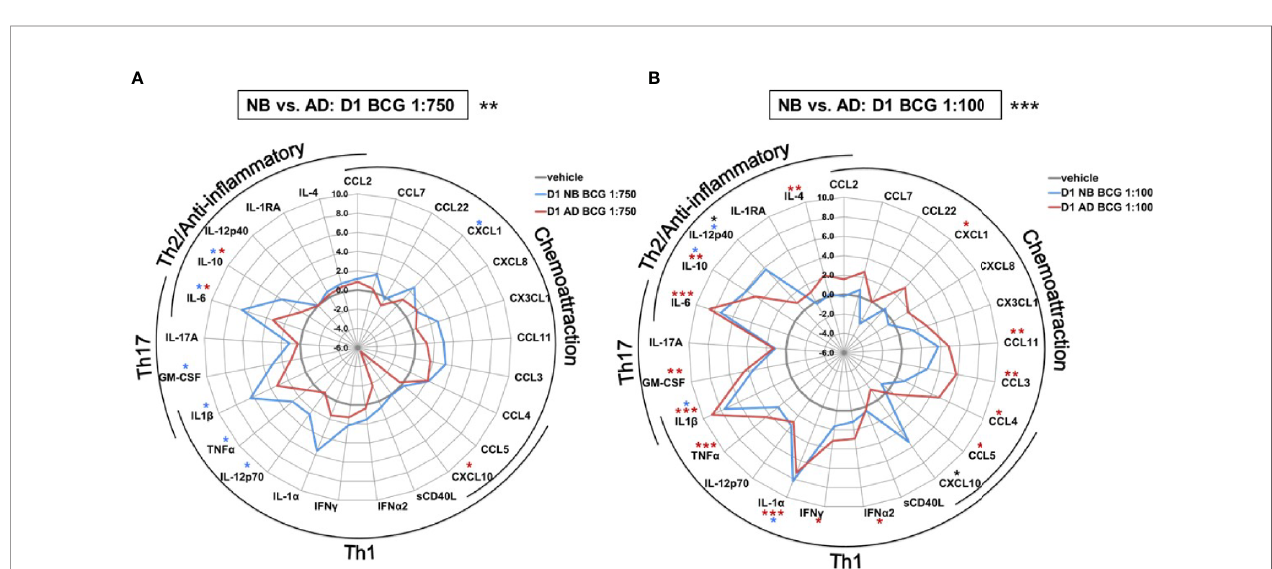
FIGURE 3 | Human newborn and adult monocytes demonstrate distinct primary BCG-induced cytokine and chemokine production at Day 1 of culture. Human newborn and adult CD33+ monocytes were cultured in vitro as described in Figure 1 then stimulated for 24 hours with (A) low (1:750 vol/vol) or (B) high (1:100 vol/ vol) concentrations of BCG prior to measurement of cytokine and chemokine production in supernatants using a multiplex assay as described in Methods . Data was normalized to RPMI control, log 2 transformed, and represents log 2 fold-change. N = 5 newborns and 7 adults; * p < 0.05; ** p < 0.01; *** p < 0.001 (blue stars: NB vs. vehicle; red stars: AD vs. vehicle; black stars: NB vs. AD). Vehicle-(re)stimulated conditions shown in